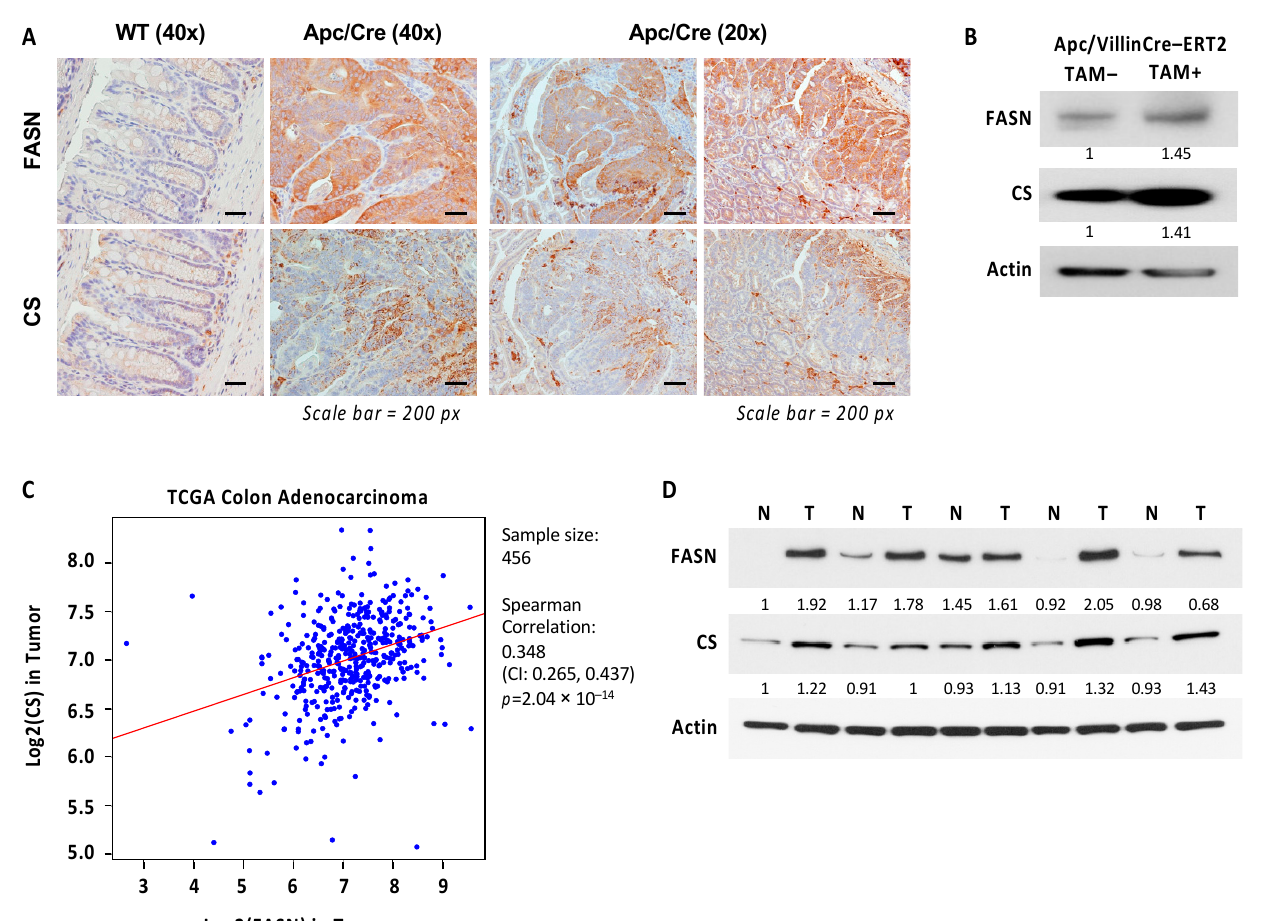
Figure 6. Expression of FASN correlates with expression of CS in CRC. ( A ) Expression of FASN and CS in intestinal tissues of wild type (WT) C57BL/6J mice and in intestinal tissues and adenomas in Apc/Cre mice. ( B ) Heterozygous deletion of Apc gene using tamoxifen (TAM) inducible Villin-Cre recombinase leads to upregulation of FASN and CS in mouse intestinal tissues. Tamoxifen was injected for 5 days, and intestinal tissues were collected on day 10 after the last injection. ( C ) Correlations between FASN and CS were determined based on RNA-Seq data of CRC patient tumor tissues (n = 456) from The Cancer Genome Atlas. ( D ) Expression of FASN and CS in human normal colon mucosa and matched tumor tissues. N-normal mucosa, T-primary tumor.